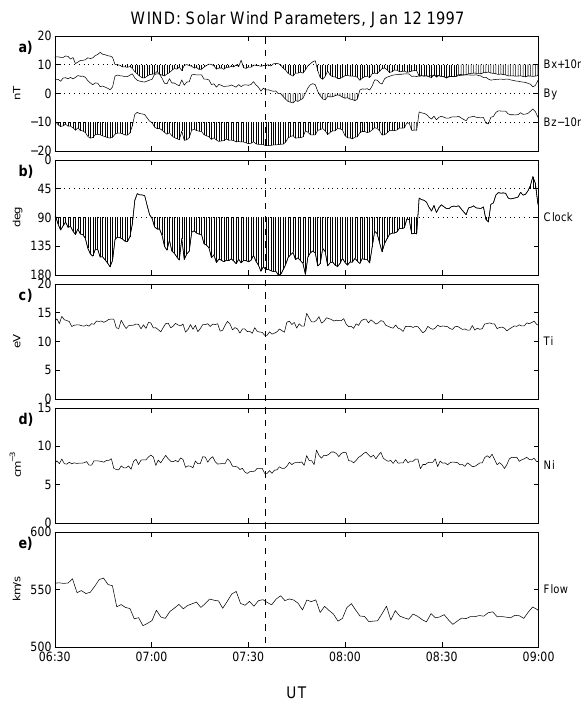
Fig. 2. Interplanetary magnetic field (IMF) and solar wind data from the Wind spacecraft for 12 January 1997: (a) the IMF B X , B Y and B Z components, (b) the IMF clock angle, (c) the ion temperature, (d) the ion density, and (e) the solar wind flow velocity. The vertical line indicates the time of the event, assuming a 25min time shift from Wind to the